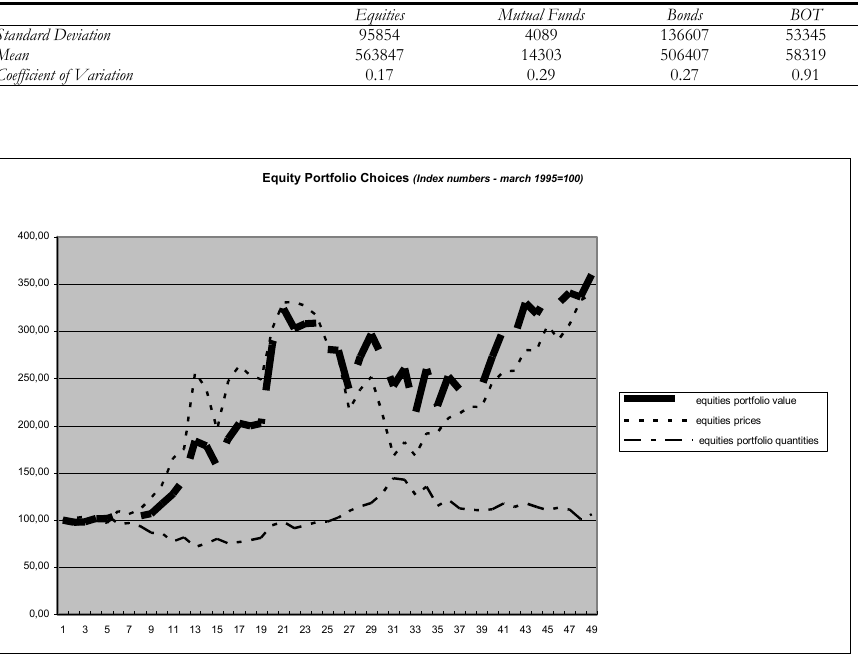
Figure 6 – Equity portfolio value, equity prices and equity portfolio quantities; our elaboration based on FA